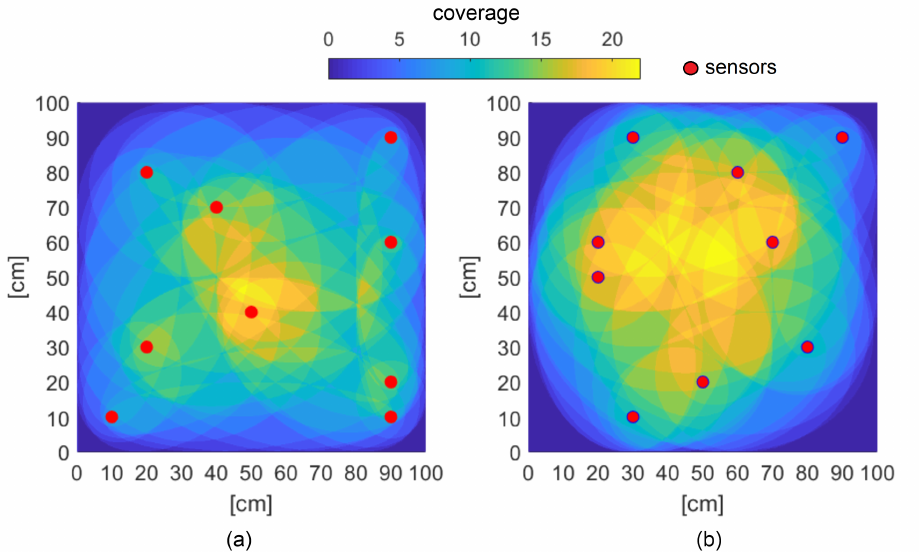
Figure 14. Surface plot showing coverage: ( a ) Optimized placement; ( b ) Random